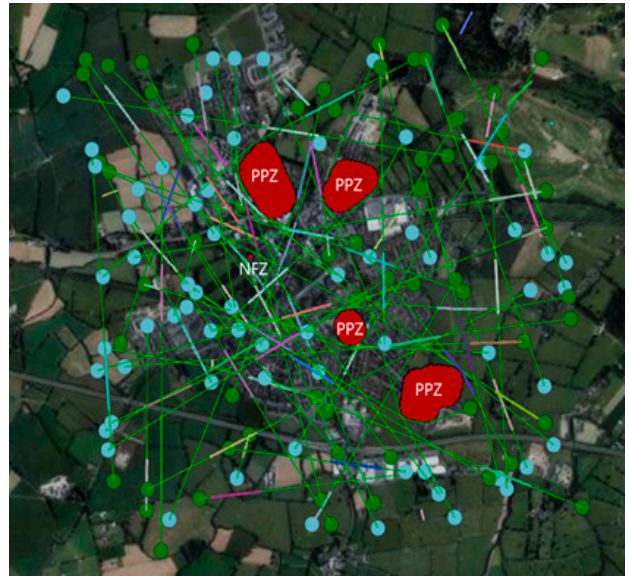
Figure 19. The output of U-Flyte’s UTM simulator at one moment during the 800 s during which drones took-off. We see a snapshot of 65 airborne drones and their given paths from their start points (green) to their end points (cyan). Note that, in this top down view, it is not possible to distinguish the layer at which each drone operates.